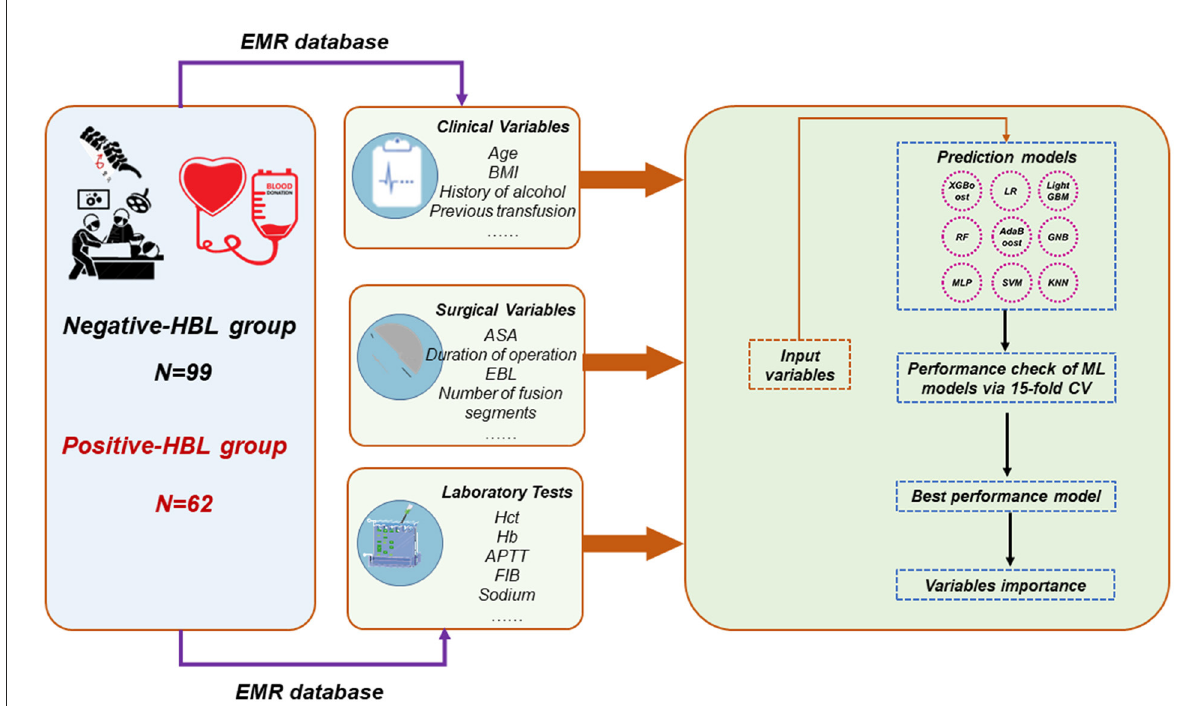
FIGURE2 Overall flowchart. The final prediction model was determined by the maximum AUC and ACC. HBL, hidden blood loss; EMR, electronic medical record; AUC, area under the receiver operating characteristic curve; ACC, accuracy; RF, random forest; GNB, Gaussian NB; MLP, multi-layer perceptron neural network; SVM, support vector machine; KNN, k-nearest neighbors; LR, logistic